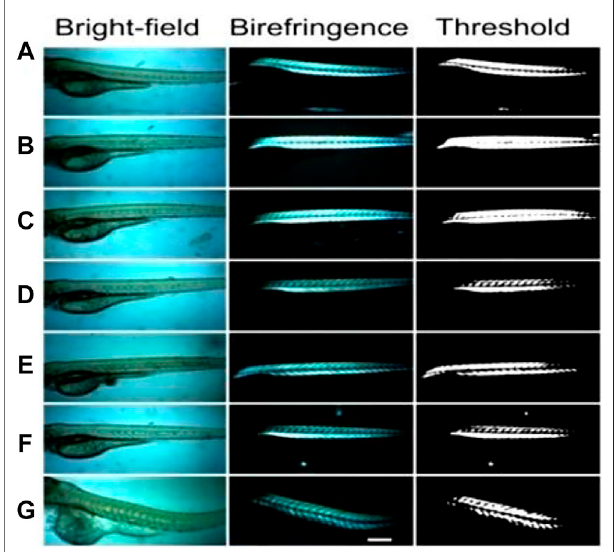
FIGURE 12 | Assessment of developmental toxicity in zebra fi sh larvae. Optical images of zebra fi sh larvae at 96 hpf for Control (A) , DMSO (B) , BaF 2 (C) , BaF 2 :Ce 3+ /Tb 3+ (D) , BaF 2 :Ce 3+ /Tb 3+ @SiO 2 (E) , BaF 2 :Eu 3+ (F) , and cypermethrin pesticide (G) . Bright- fi eld images showing complete skeletal muscles, yolk sac, yolk tube, and pericardial area of zebra fi sh larvae. Birefringence images showing the structural integrity of skeletal muscles of zebra fi sh larvae for the respective treatment group. Threshold images are binary birefringence images showing the area of zebra fi sh larvae having bright pixels falling within a pixel intensity gate of 100 – 255 values. Scale bar (cid:2) 0.2 mm (Sharma et al.,